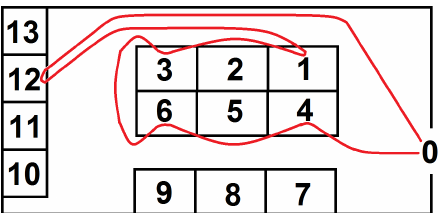
Figure 5. A sample route (in red) connecting the locations 0, 4, 6, 2, 1, 12 determined with the Nearest Neighbor